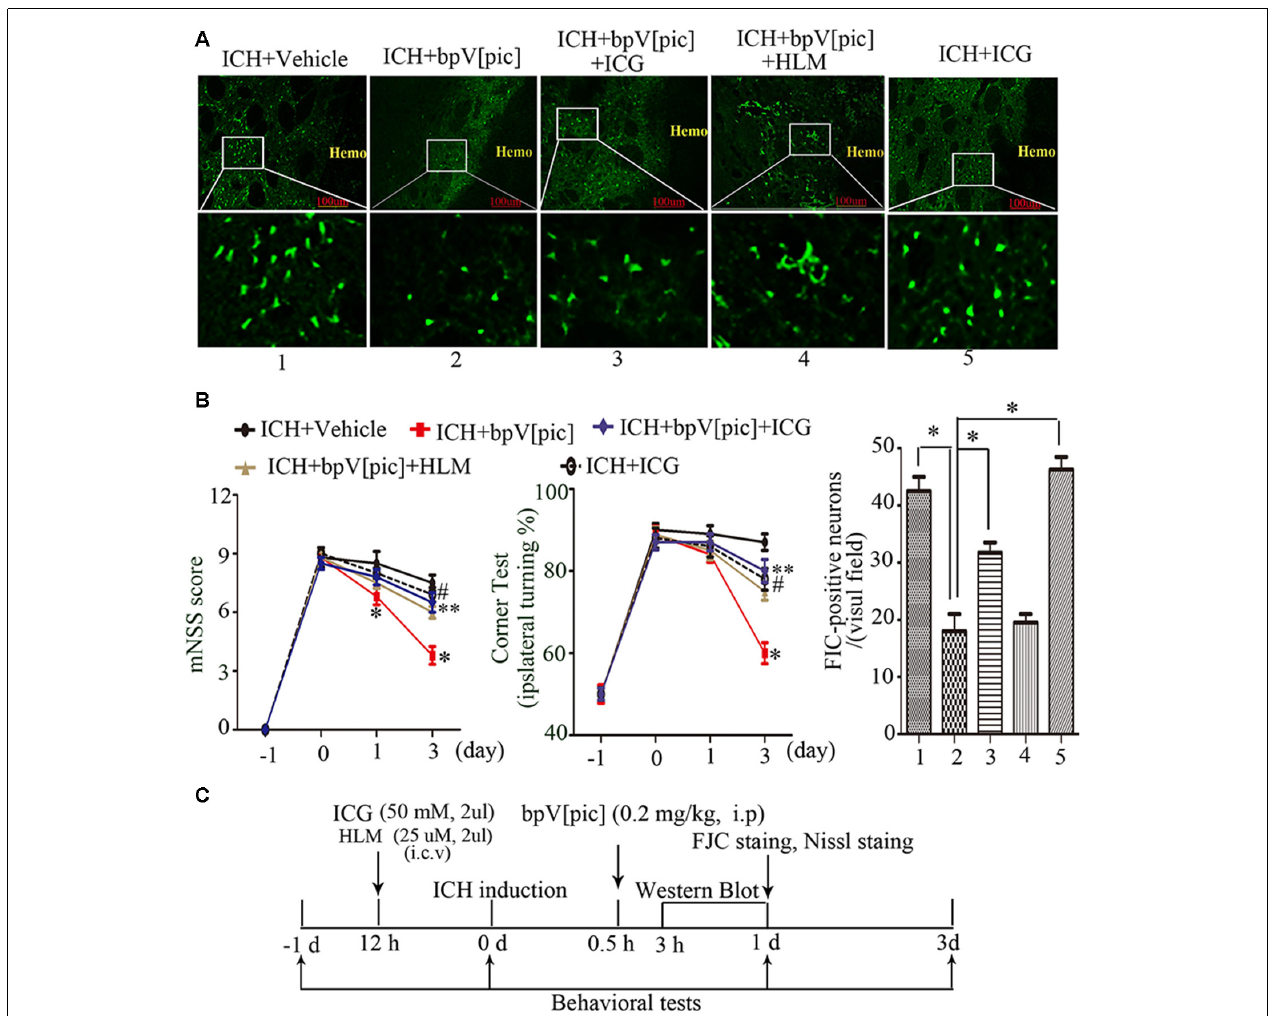
FIGURE 7 | BpV[pic] attenuated brain injury through PTEN/E2F1/ β -catenin pathway after rat experimental ICH. (A) Representative microphotographs of FJC-positive neurons in the peripheral tissues of hematoma after ICH. Compared with vehicle recipients, bpV[pic] reduced the FJC-positive neurons. ICG-001 blocked the protective effect of bpV[pic] against ICH-induced brain injuries ( ∗ P < 0.05 , one-way ANOVA test, followed by Bonferroni post hoc test, N = 8). (B) Rats with bpV[pic] injection have lower scores of modified Neurological Severity Score (mNSS) test and corner test at days 1 and 3 after ICH. Rats preinjected with ICG-001 have higher scores of mNSS test and corner test at day 3 after ICH ( ∗ P < 0.05, ICH+bpV[pic] vs. ICH+Vehicle; ∗∗ P < 0.05 , ICH+bpV[pic]+ICG vs. ICH+bpV[pic]; # P < 0.05, ICH+ICG vs. ICH+bpV[pic]; two-way ANOVA test, followed by Bonferroni post hoc test, N = 8). (C) A diagram shows the experimental procedures in ICH rats. ICH animals were subjected to three times of bpV[pic] intraperitoneal injection for the interval of 4 h 0.5 h after ICH induction. ICG-001 and HLM006474 were administered 12 h before ICH. FJC and Nissl staing were analyzed at 1 day after ICH. Behavioral tests were conducted 1 day before and 0, 1, 3 days after ICH induction (HLM, HLM006474; ICG,